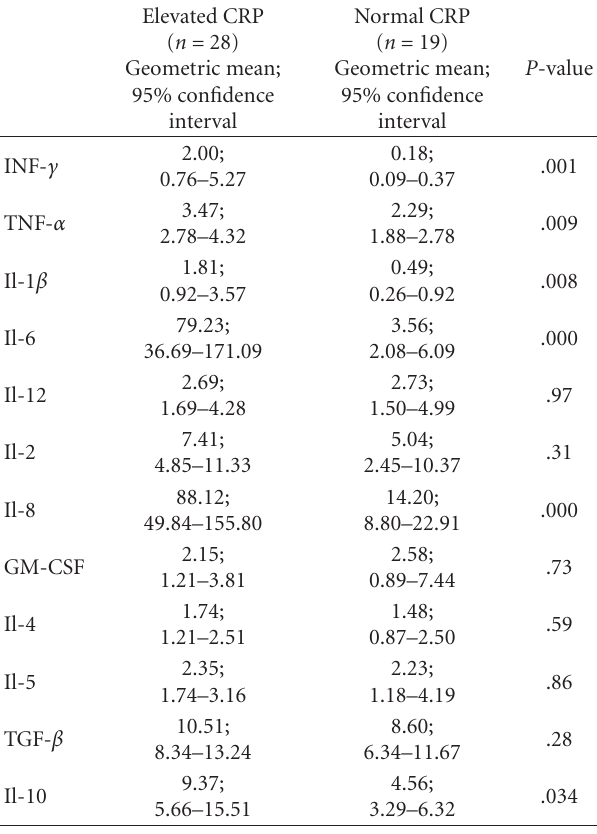
Table 2: Cytokine levels for patients with elevated C-reactive protein and patients with normal C-reactive